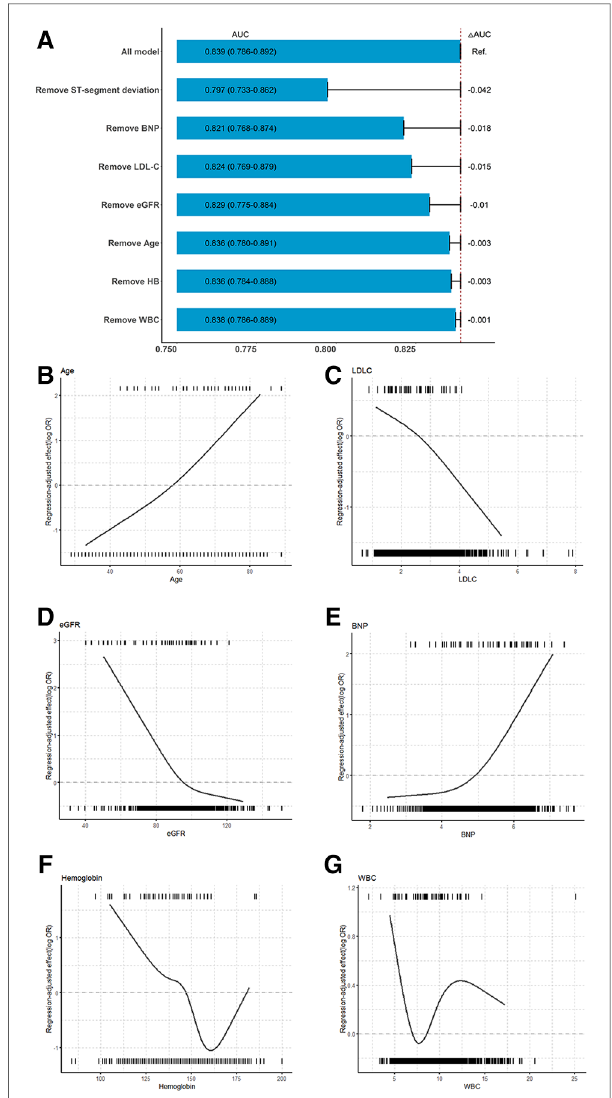
FIGURE 3 Association between continuous predictors and MACEs and importance of selected variables in iPROMPT. ( A ) The contribution of each selected variables in the iPROMPT score. ( B – G ) Regression-adjusted effects of selected continuous covariates in iPROMPT showed their association with MACEs following STEMI. The top of each fi gure shows the observed values of the continuous risk predictor among STEMI patients in the derivation cohort who experienced MACEs and the bottom shows the observed values of the predictor among those who did not experience MACEs. MACEs risk increased with age ( B ) and decreased LDL-C ( C ). MACEs risk declined with eGFR ( D ), and plateaued at over 100 ml/min/1.73 m 2 . ( E ) The risk associated with log (BNP) remained fl at and increased when log(BNP) >5. The U-shaped association observed between hemoglobin ( F ), and WBC ( G ) and MACEs. AUC, area under the curve; BNP, B-type natriuretic peptide; eGFR, estimate glomerular fi ltration rate; WBC, white blood cell